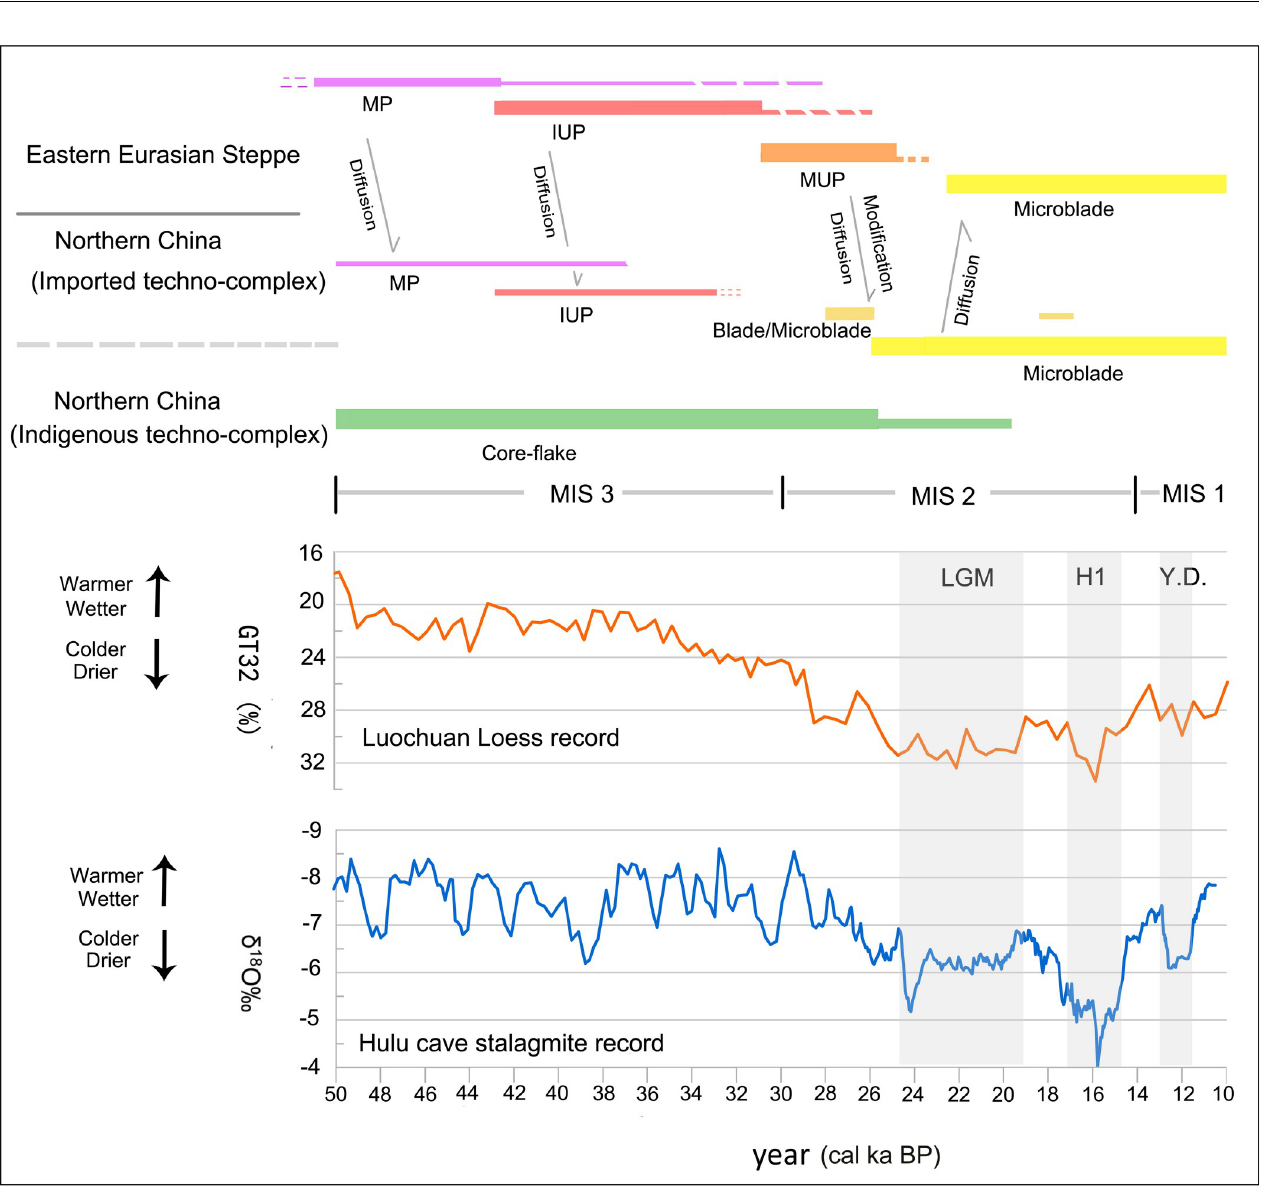
Fig 10. Temporal correspondences between cultural changes and climatic fluctuations in northern China and the eastern Eurasian Steppe (Mongolia, South Siberia) during 50–11 cal. ka BP. The paleoclimate curve was made based on the data from [135] and [136].